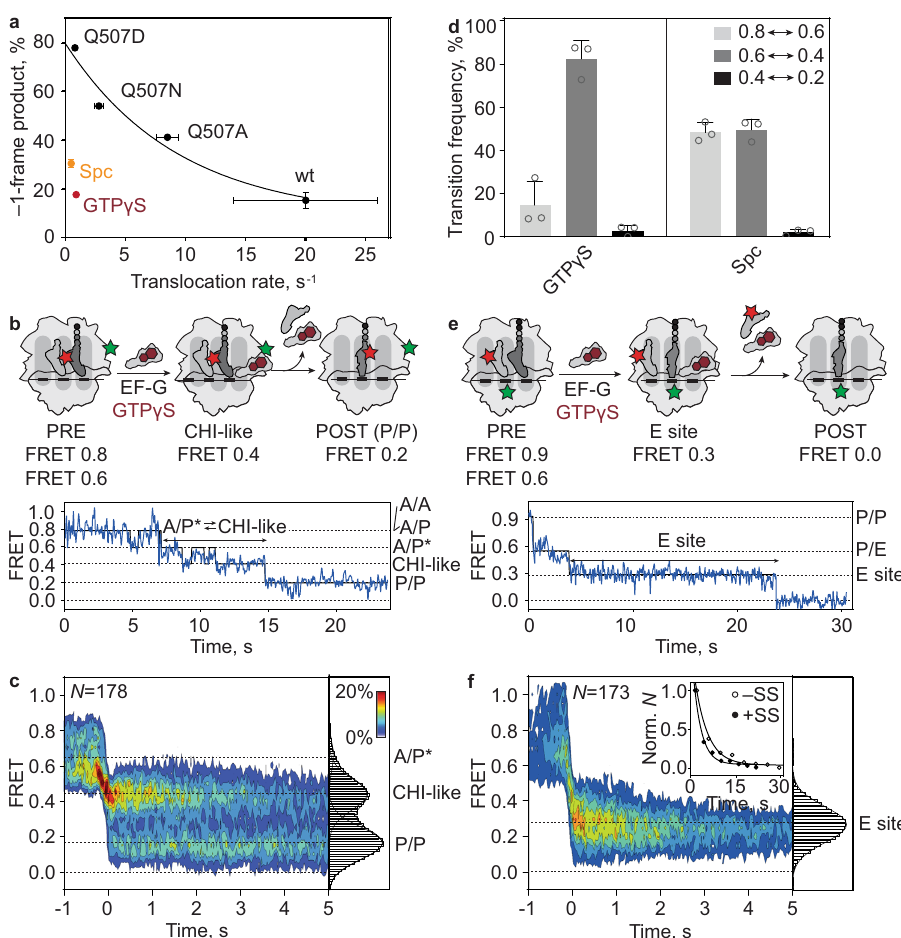
Fig. 5 Translocation on slippery mRNA with EF-G(wt) — GTP γ S. a Correlation between frameshifting and ensemble translocation rate. Frameshifting was measured at 37 °C, data are presented as mean ± s.d. from three independent experiments ( N = 3). Translocation rates of EF-G(wt) and Q507 mutants are from ref. 16 , of GTP γ S (brown) from ref. 54 , and of Spc (orange) from 73 . b Above: schematic of smFRET experiment monitoring movement of pept- tRNA Lys -Cy5 (red stars) relative to L11-Cy3 (green star) by EF-G(wt) — GTP γ S (brown hexagon) binding to immobilized PRE complexes. Below: representative smFRET trace of pept-tRNA translocation by EF-G(wt) — GTP γ S with fl uctuations between FRET 0.8 (A/A, A/P) and 0.6 (A/P*) followed by fl uctuations between FRET 0.4 (CHI) and 0.6. c Contour plot showing the distribution of FRET values during translocation of pept-tRNA on slippery mRNA by EF-G(wt) — GTP γ S. Traces are synchronized to the fi rst transition below FRET 0.5. Histogram at the right shows the distribution of FRET values after synchronization. Data are from six independent experiments ( N = 6). d Transition frequencies between FRET states during pept-tRNA translocation on slippery mRNA by EF-G(wt) — GTP γ S (Supplementary Fig. 7b and Table 1) and in the presence of Spc (Table 1). Data are presented as mean ± s.d. from 6 relative to protein S13-Cy3 (green star) during translocation induced by addition of EF-G(wt) – GTP γ S to immobilized PRE complexes. Below: representative smFRET trace of translocation by EF-G(wt) — GTP γ S with step-wise transition from FRET 0.9 (P/P) to 0.6 (P/E) to 0.3 (E) to 0.0 (dissociation). f Contour plot showing the distribution of FRET values during translocation of deacylated tRNA on slippery mRNA by EF-G(wt) — GTP γ S. Inset shows rates and curve fi t of tRNA dissociation from E site on slippery (closed circles) and non-slippery (open circles) mRNA (Supplementary Fig. 7c and Table 2). Normalization was performed by division by the number of transitions ( n ). Data are from 3 independent experiments ( N =